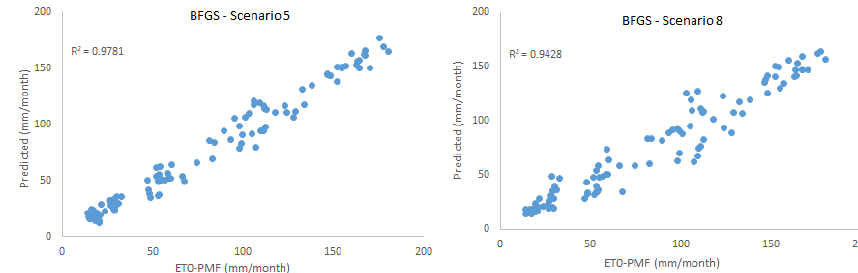
Figure 8. Scatter plots comparing BFGS-ANN-estimated and FAO56PM-estimated ET 0 in scenarios 5 and 8.